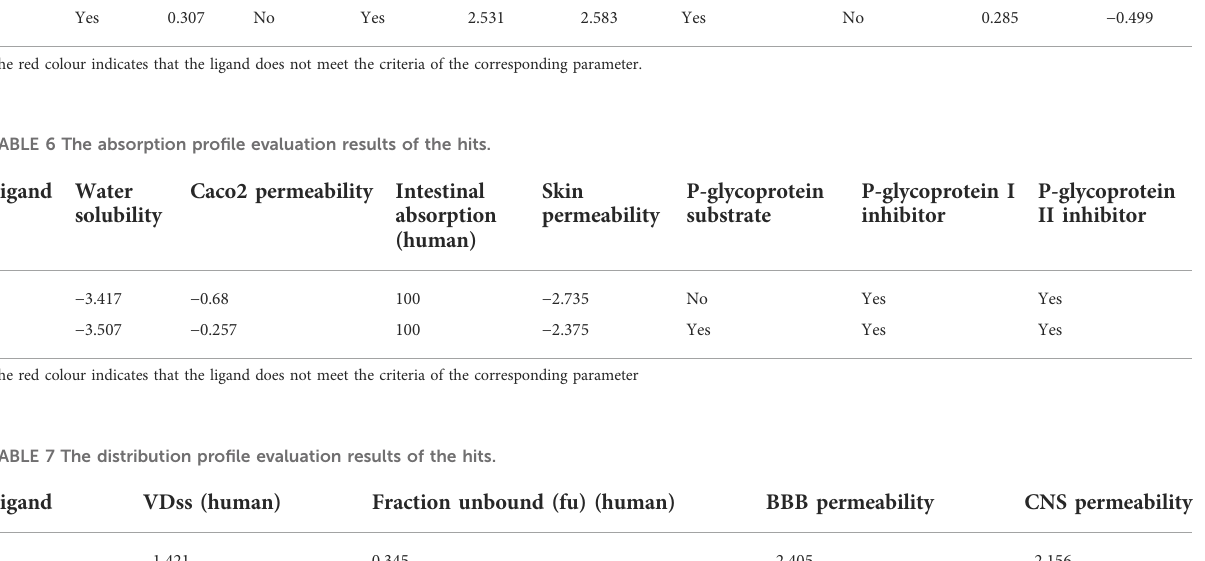
The red colour indicates that the ligand does not meet the criteria of the corresponding